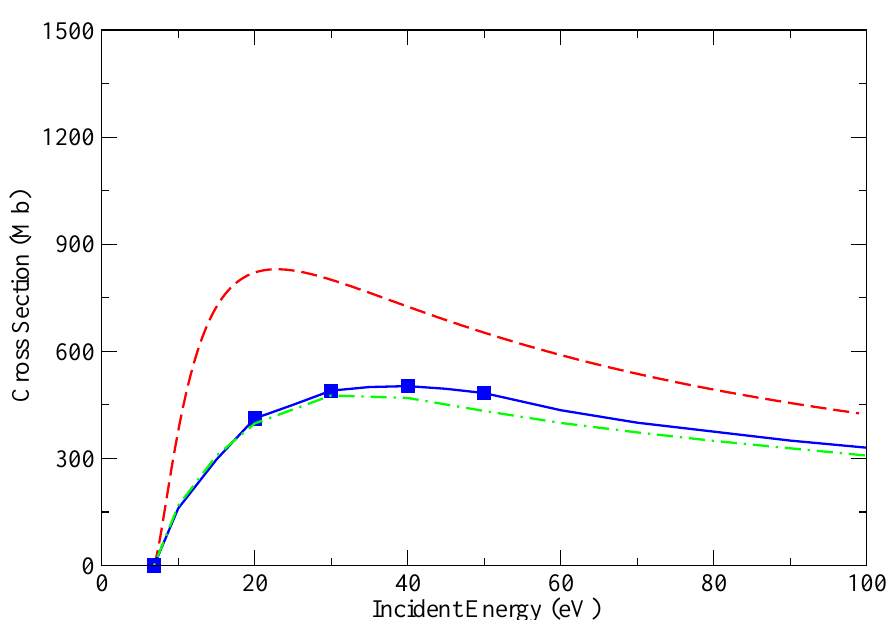
Figure 6. Electron-impact direct ionization of the 6 p subshell of Pb. Dashed line (red): distorted-wave method with a polarization potential, solid line with squares (blue): time-dependent close-coupling method with a polarization potential, dot–dash line (green): convergent close-coupling method [9] with a polarization potential (1.0 Mb = 1.0 × 10 − 18 cm 2 ).